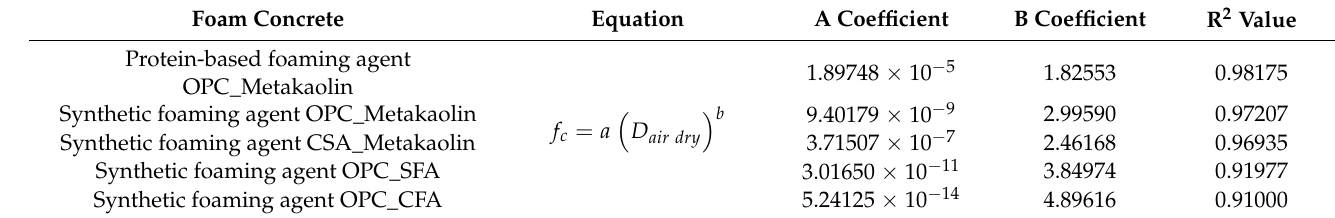
Table 6. Coefficients for the power fit—compressive strength ( f c